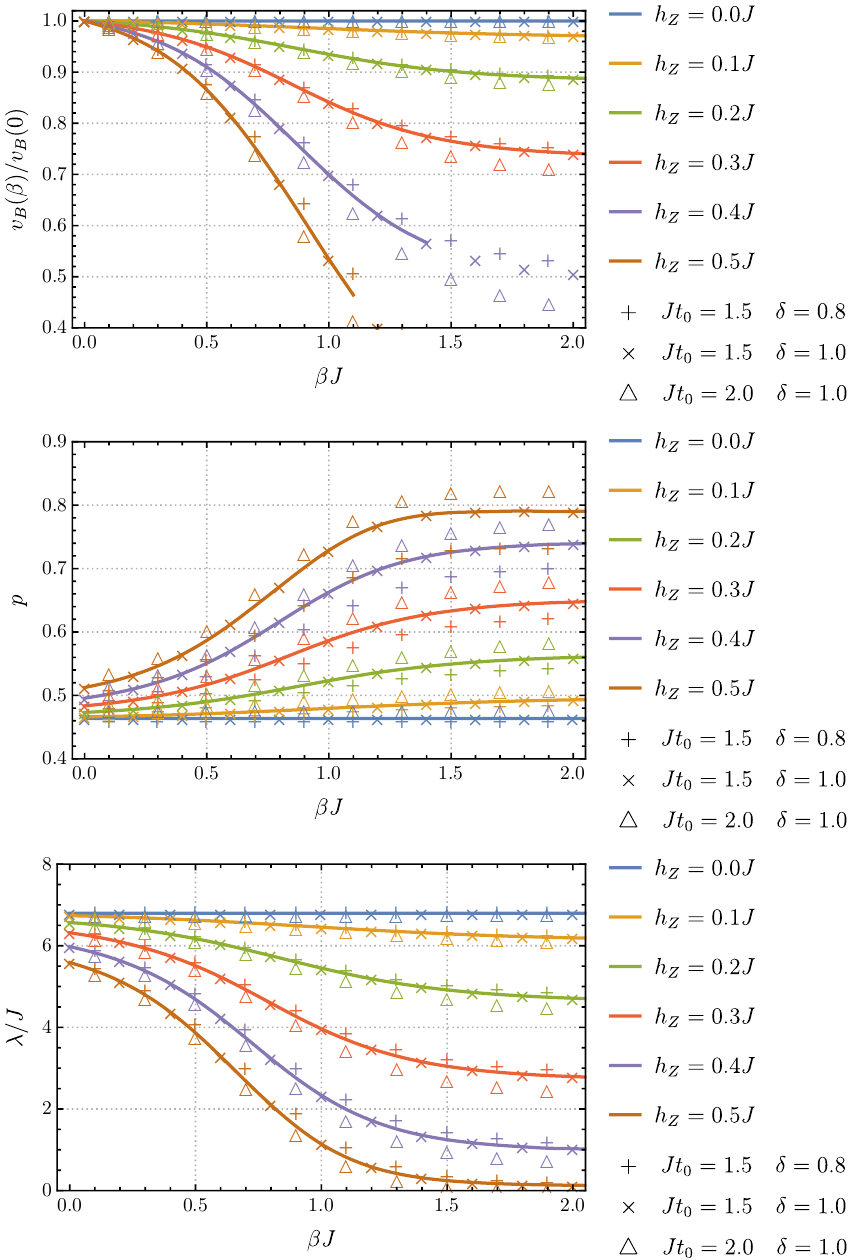
Figure 7: Scrambling characteristics in (2) fitted for numerics in mixed field Ising = 1.05 J , different longitudinal field h chain (21) with h , inverse temperature β X Z = 4.4). Solid curves are guides to the eye and hyperparameters t and δ (with J t 0 1 = 1.5 and δ = of fits at J t 0